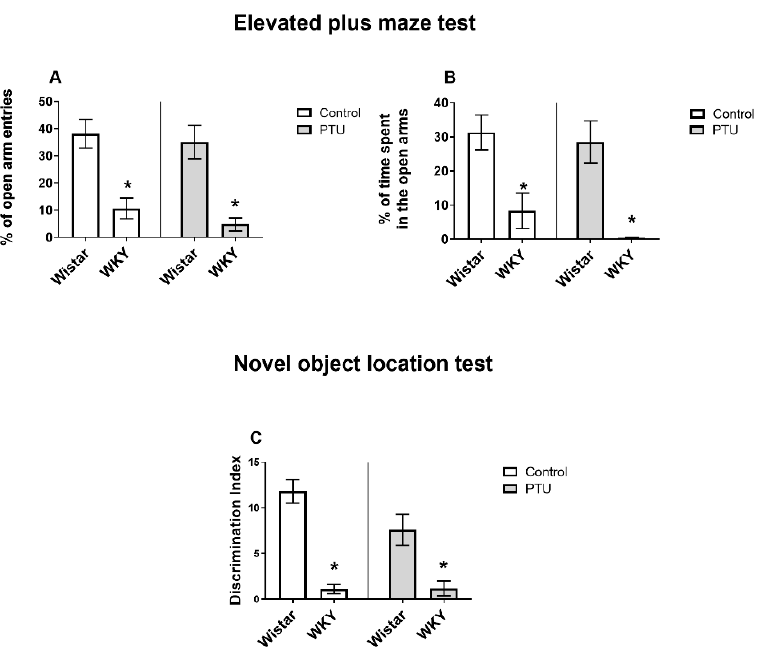
Figure 1. The effects of strain and propylthiouracil (PTU) treatment on the % of open arm entries ( A ) and % of time spent in the open arms ( B ) measured in the elevated plus maze test and on the object discrimination index ( C ) measured in the novel object location test. The results are expressed as the mean ± SEM. * p < 0.05 vs. the control group (Wistar rats). n = 8–10.